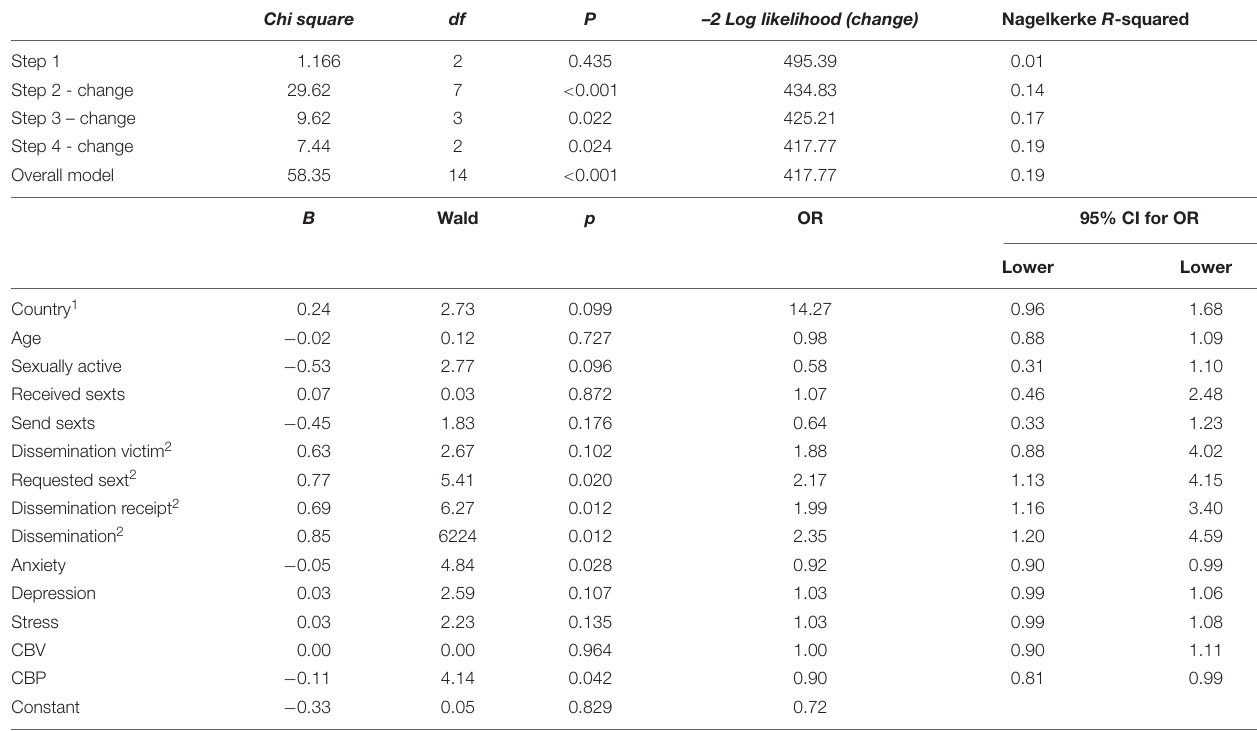
TABLE 5 | Regression results – predictors of OIBEV site visitation for